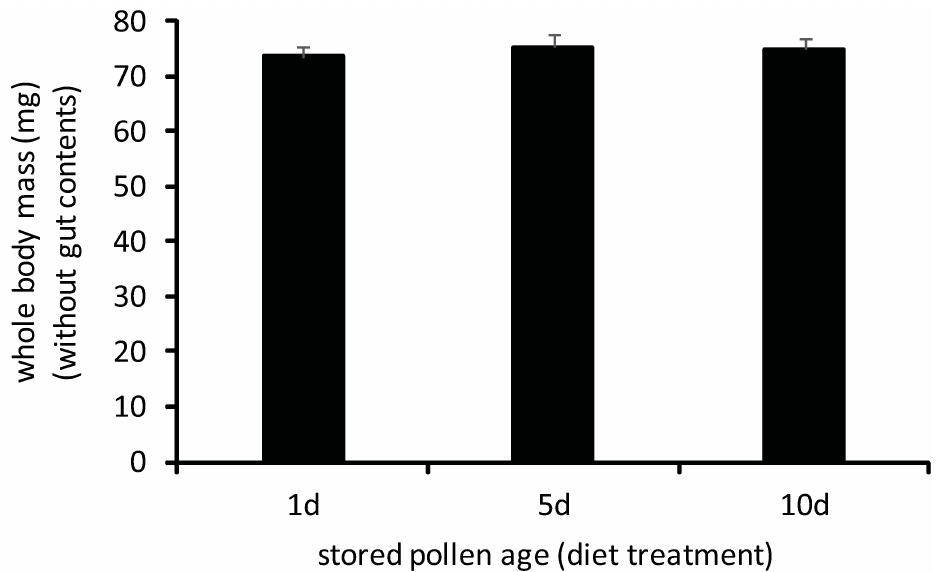
Fig 5. Whole body mass (fresh mass without gut contents) of adult workers rearedexclusively for 7d on 1d-old, 5d-old, or 10d-old stored pollen. Treatment means did not vary significantly by a one-way ANOVA. (p < 0.05; error bars are S.E.).